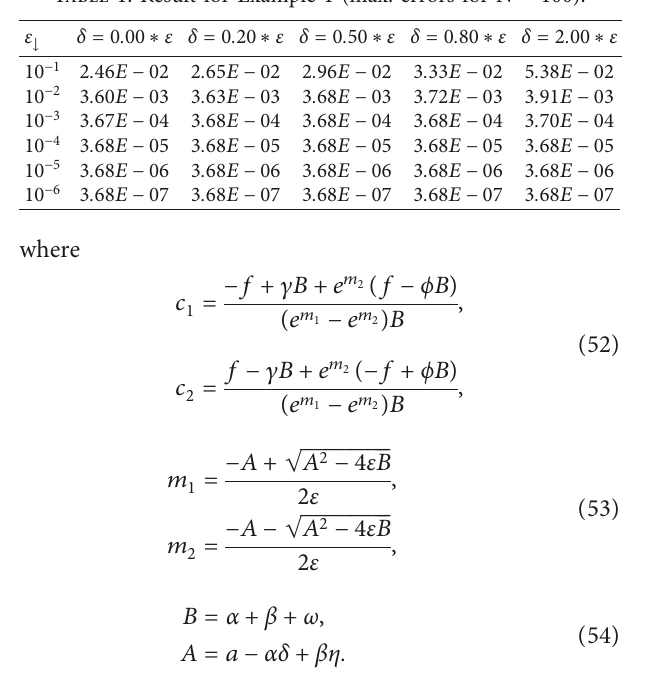
Table 1: Result for Example 1 (max. errors for N �